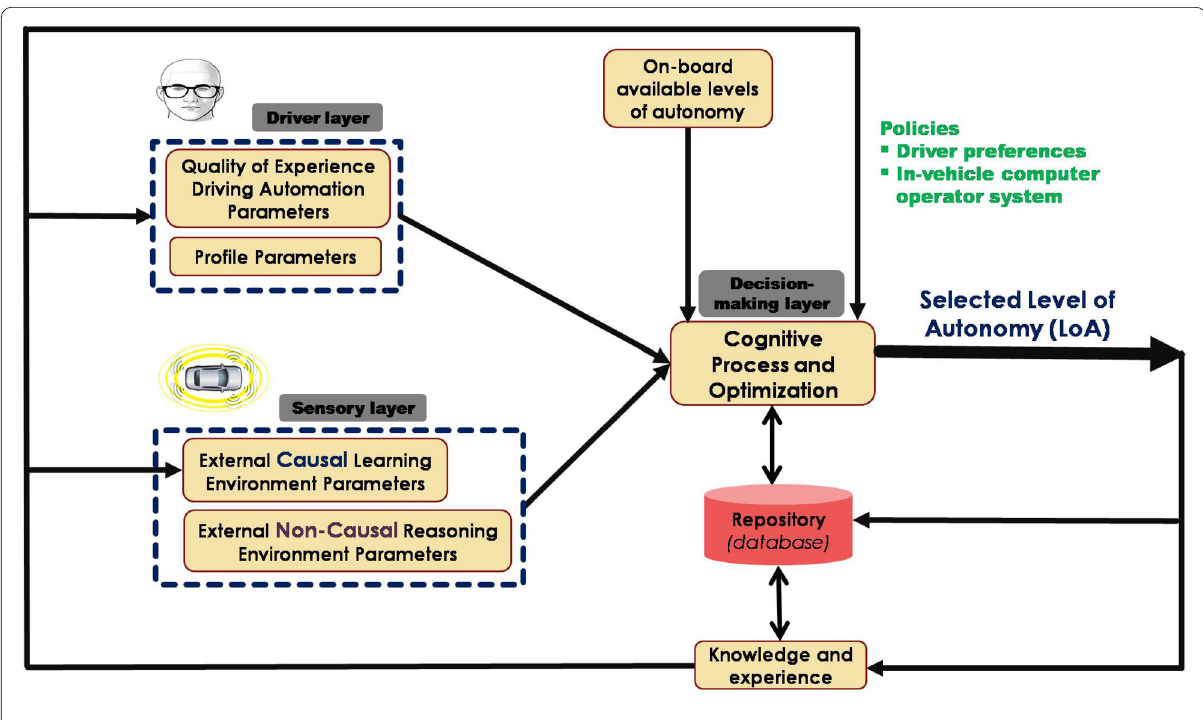
Figure 1 ‘CLoAS’ high-level architecture